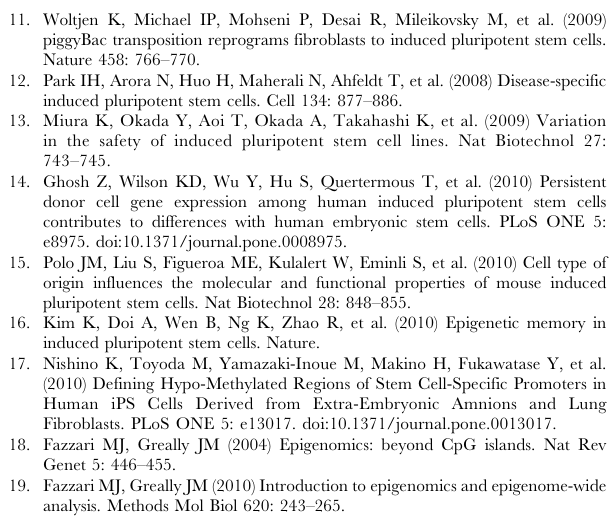
Figure S7 (A) Distribution of stem cell-required DMRs on each chromosome (upper) and frequency on each chromosome (bottom). (B) The number of parent cell specific DMRs (left) and the number of iPSC derived from different parent cells specific DMRs (left). Figure S8 The number of DMRs between ESCs and each iPSC line (ES-iPS-DMRs) on each chromosome. ES-iPS-DMRs be- tween 201B7 (iPSCs from Yamanaka) and ESCs are shown for comparison. Figure S9 Distribution of the ES-iPS-DMRs on each chromo- some. Distribution of the EiP-DMRs overlapped in less than 9 lines (light blue bars), in more than 10 and less than 14 lines (blue bars), and in more than 15 lines (red bars) among 22 lines. Figure S10 DNA methylation at human MEG3 and H19 . (A) DNA methylation at MEG3-DMR (CG7) and expression of MEG3. (Top) Schematic diagram of the MEG3 gene. The arrow, open boxes and open circles represent transcription start site, first exon and position of CpG sites, respectively. Red and blue arrowheads represent the position of CpG sites in Infinium assay and COBRA assay, respectively. DNA methylation scores of MEG3 were determined by Illumina Infinium HumanMethyla- tion27 assay (upper bar graph) and Bio-COBRA (lower bar graph). (Bottom) Expression of MEG3 and GAPDH was determined by RT-PCR. Information of MEG3 primers for COBRA and RT-PCR is described by Kagami et al. [40]. (B) Bisulfite sequencing analysis of MEG3-DMRs (CG7). Infinium HumanMethylation27 assay.